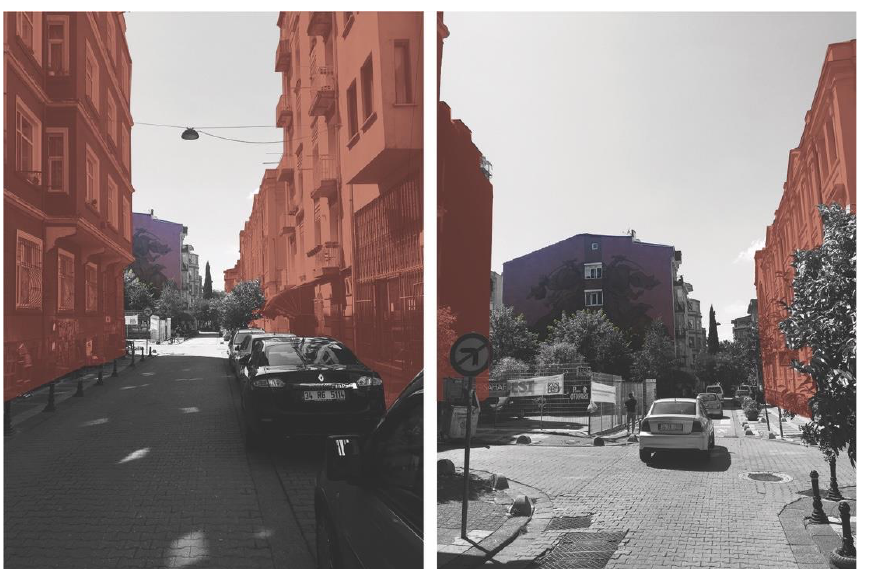
Figure 11 The serial vision on a selected street in the neighborhood exemplifies the change in the enclosure level and a perceived increase in the visual manifestation of the mural in the fabric.